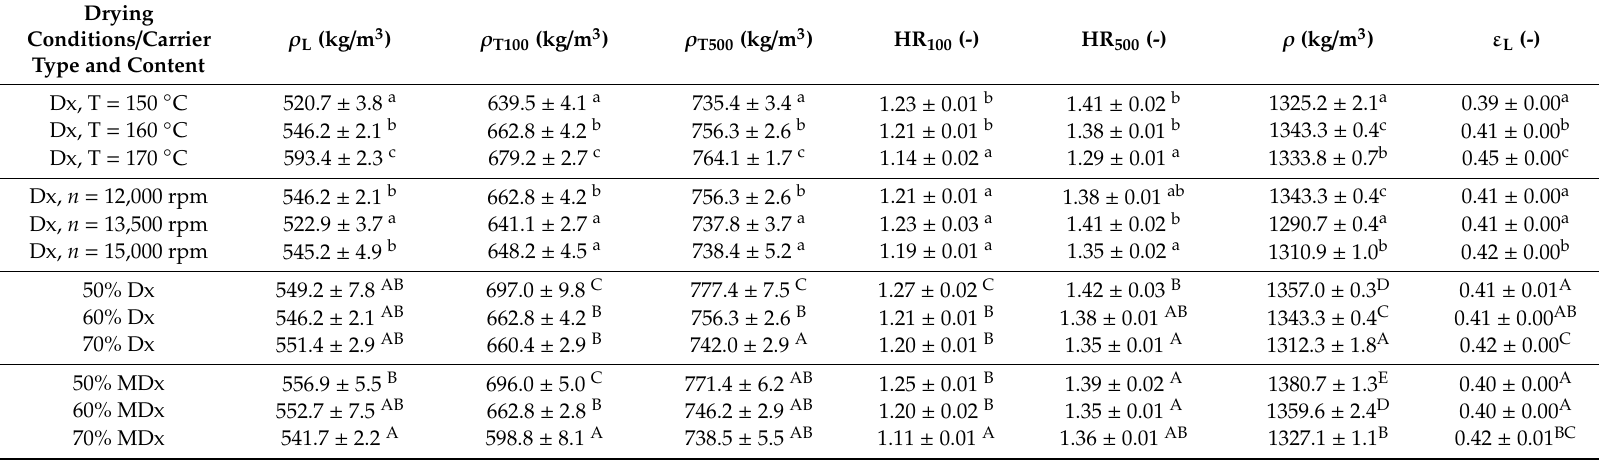
Table 2. Loose bulk density ( ρ L ), tapped bulk density ( ρ T100 and ρ T500 ), Hausner ratio (HR 100 and HR 500 ) as a flowability, apparent density ( ρ ) and bulk porosity of loose powder bed ( ε L